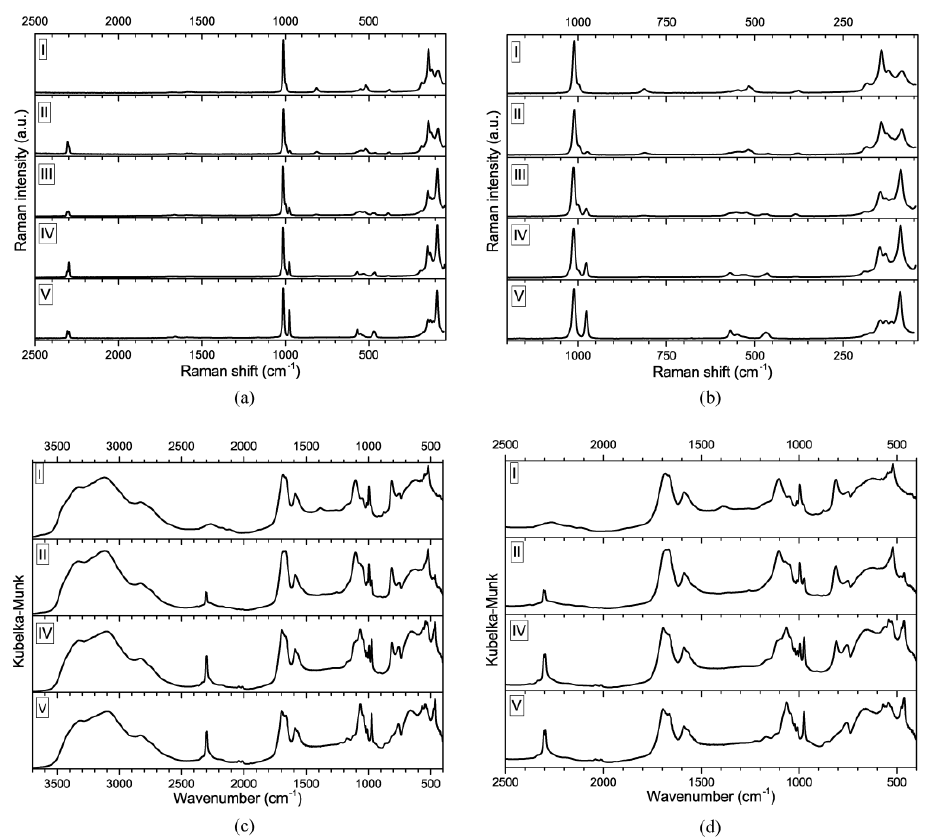
Figure 6. ( a ) Raman spectra of the series of Gu 2 (PO 3 F) x (HPO 3 ) y — compounds ( I )–( V ); ( b ) Detail of the Raman spectra of compounds ( I )–( V ) (region 1200–50 cm − 1 ); ( c ) DRIFT spectra of the series of Gu 2 (PO 3 F) x (HPO 3 ) y— compounds ( I ), ( II ), ( IV ) and ( V ); ( d ) Detail of the DRIFT spectra of compounds ( I ), ( II ), ( IV ) and ( V ) (region 2500–400 cm − 1 ). Table 6. Comparison of the relative peak area of two bands of stretching PH